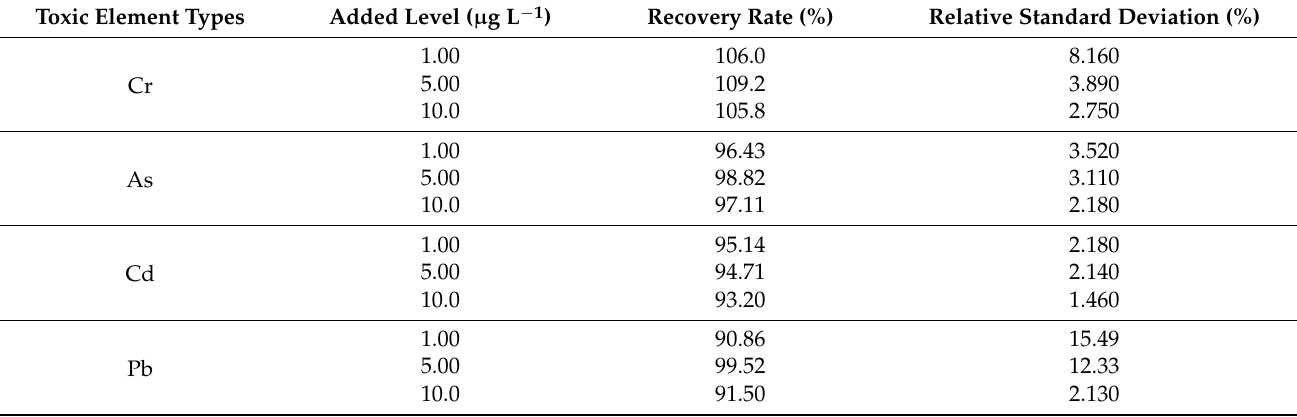
Table 2. Spiked recovery and relative standard deviation of toxic elements in chicken ( n =